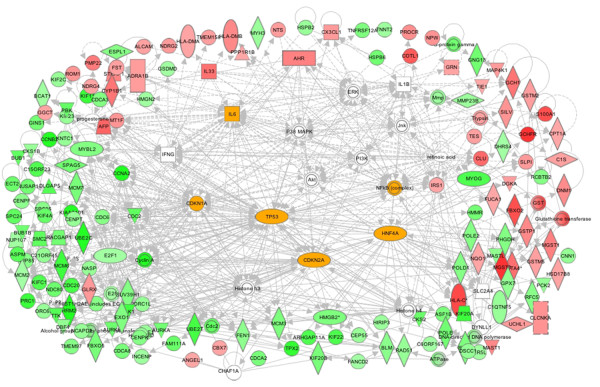
Major intracellular networks of cardiac genes that were differentially modulated by CBHA at 24h. The dominant nodes, centered by IL-6, TP53, CDKN1A, CDKN2A, HNF-4A and NFkB are highlighted; signaling nodes of ERK-JNK-p38MAPK are also present as prominent node.